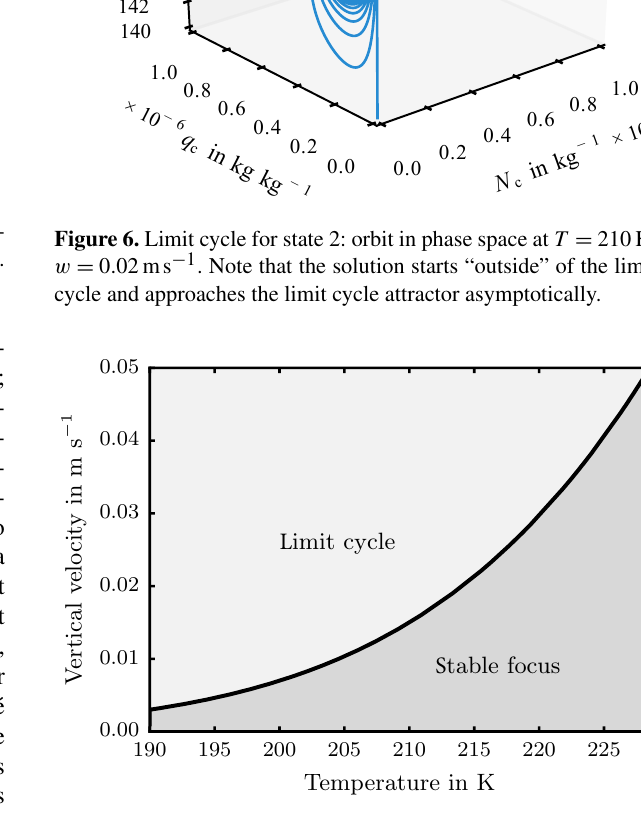
Figure 7. Bifurcation diagram for stable focus (state 1) and limit cycle (state 2) regimes in the w – T space. The thick line indicates the location of the Hopf